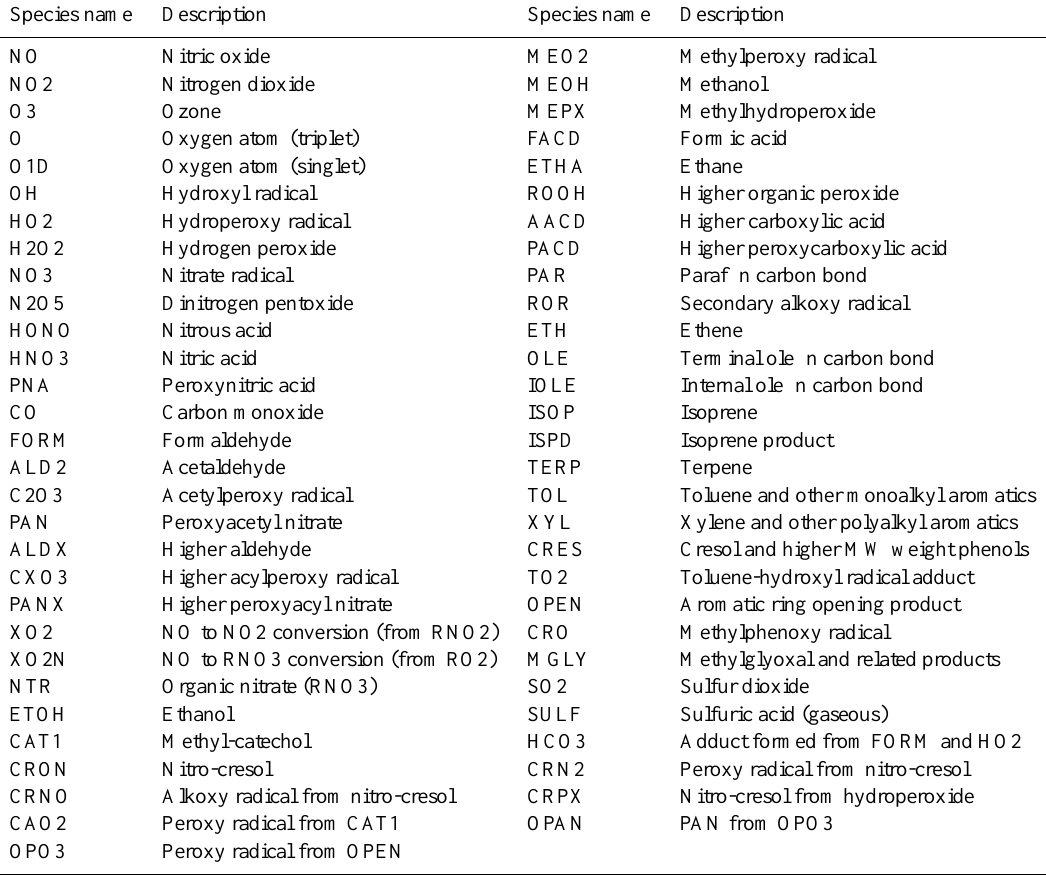
Table 1. Model chemical species in CB05TU ∗ (Yarwood et al., 2005; Whitten et al.,